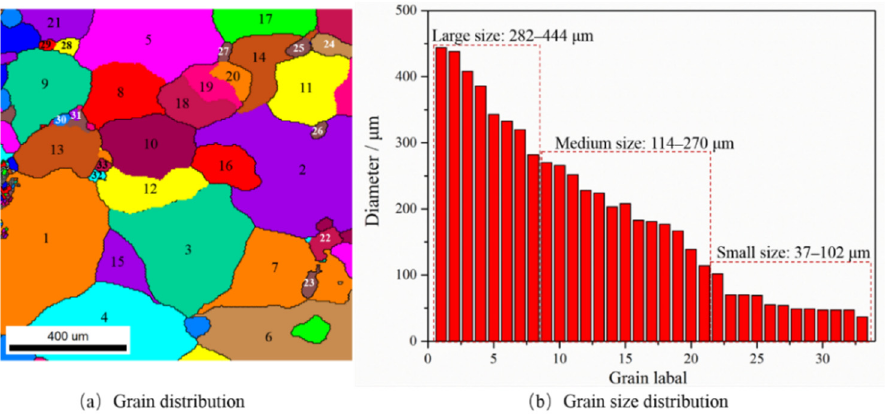
Figure 5. Grain and their grain-size distribution observed by EBSD. The grain orientations of the surface grains, with random Schmidt factors, were randomly distributed in the initial state and then inevitably deflected with stretching.